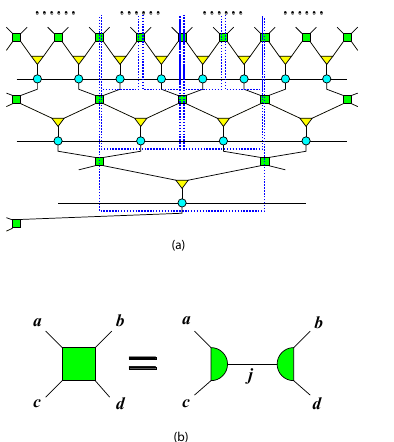
Figure 13 . (a) The RT surfaces (blue curves) in the MERA-like tensor network. (b) The decom- position of disentangler tensor u . (c) The corresponding representation of W tensor in MERA-like tensor